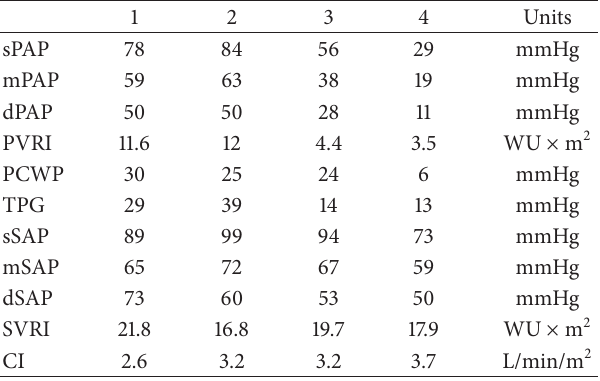
Table 1: Hemodynamic measurements and calculated values before and after heart transplantation: time course before (1) and after levosimendan (2), with bosentan/epoprostenol (3) and after heart transplantation